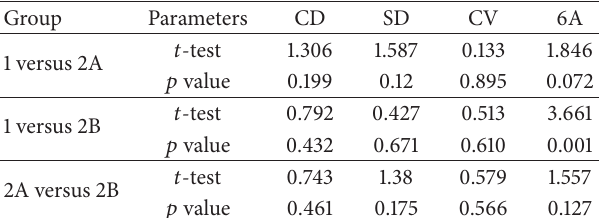
Table 3: Statistical analysis of the differences between pre- and postoperative data for the three groups (CD: cell density; SD: standard deviation; CV: coefficient of variation; 6A: hexagonality